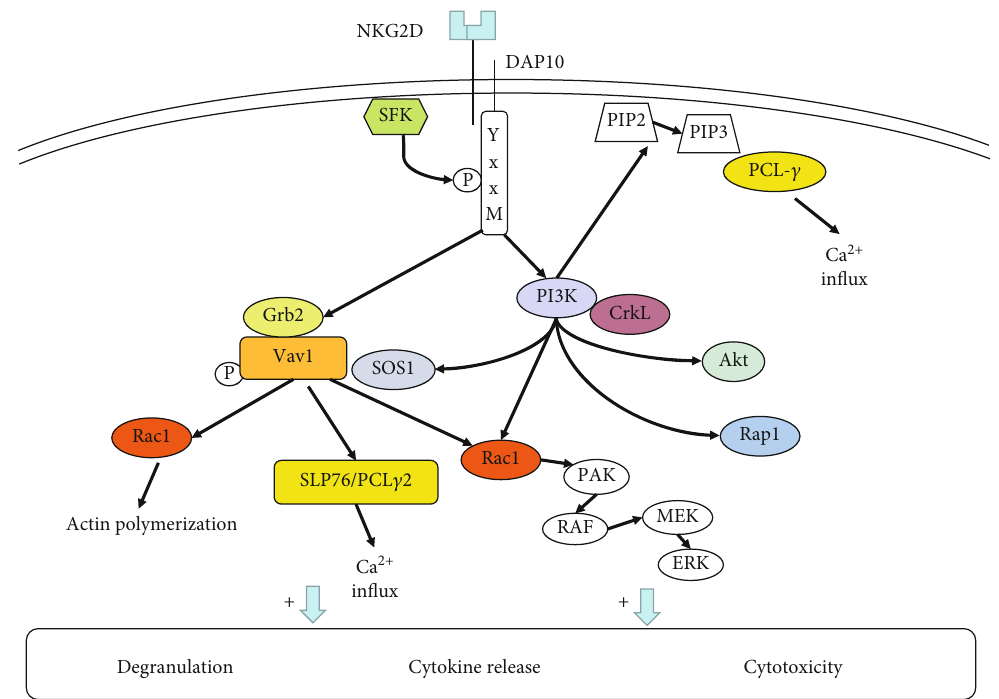
Figure 3: NKG2D signaling pathways. After DAP10 associates with NKG2D, it can bind to PI3K and the Grb2-Vav-1-SOS1 complex. The Grb2-Vav-1-SOS1 complex activates SLP76, PLC γ 2, and Rac1. Rac1 can activate the MAPK signaling pathway and promote actin polymerization. SLP76/PCL γ 2 causes Ca 2+ in fl ux. Furthermore, it leads to cellular degranulation and secretion of cytokines. PI3K can recruit PCL- γ , Rac1, and Akt signaling molecules to activate NK cell function. In addition, PI3K can recruit the SOS1-Grb2-Vav1 complex via SOS1 and recruit the small Ras-family GTPase Rap1 with the help of CrkL to achieve